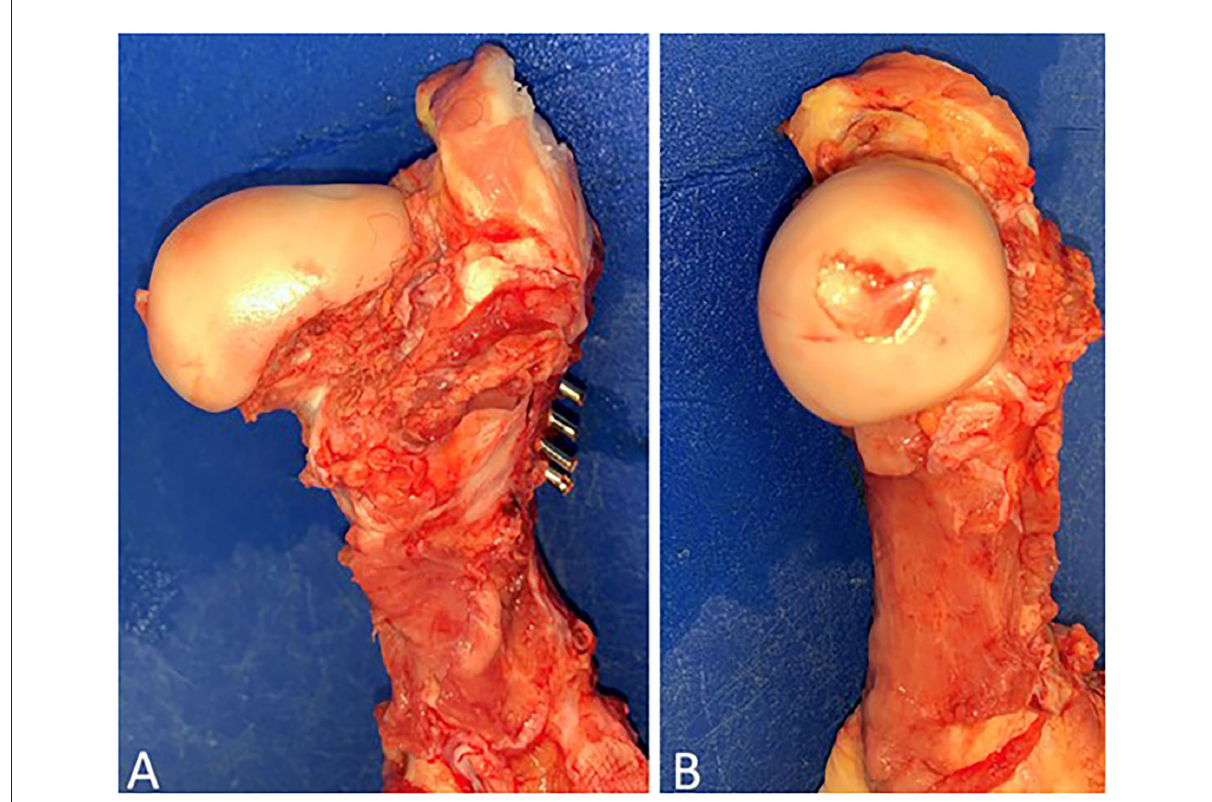
FIGURE4 Gross post-mortem exam of the left hind proximal femur of case 1. Note adequate reduction and fixation without the presence of articular compromise. (A) Cranial-caudal and (B)